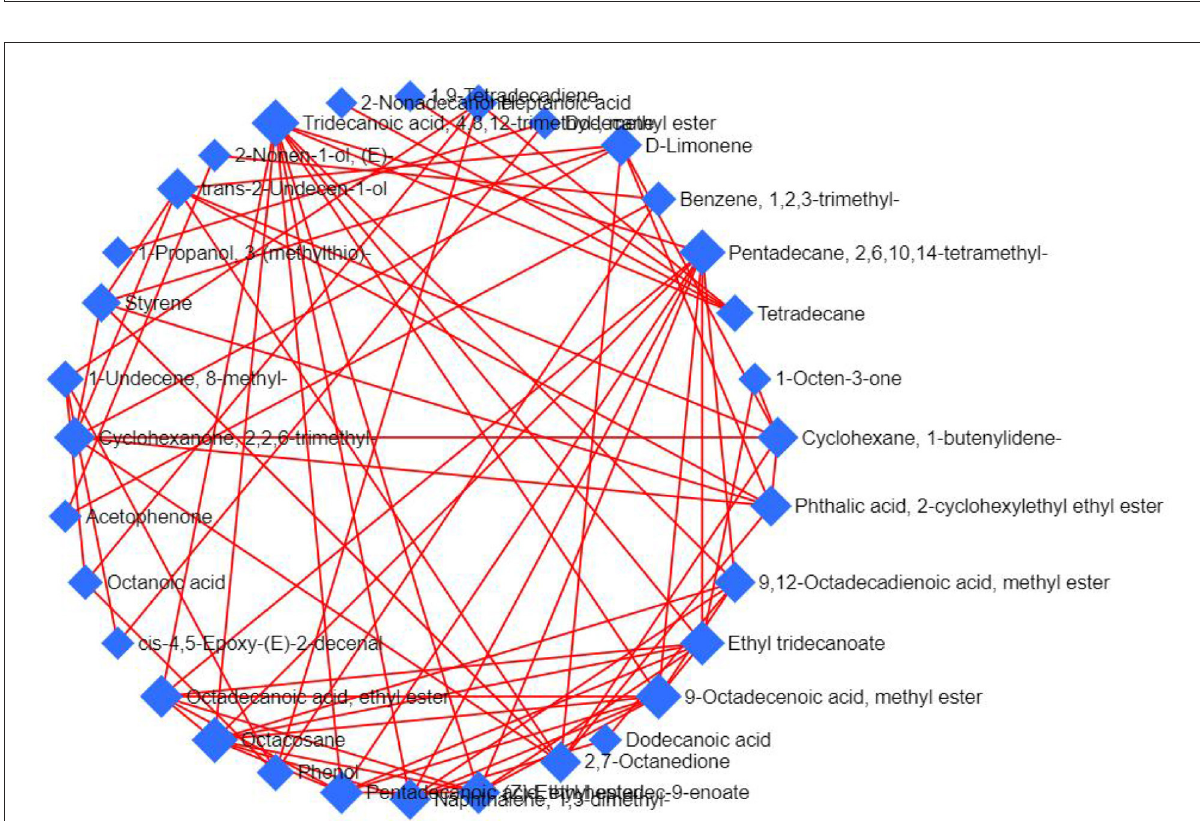
FIGURE8 DSPC volatile components network. The network was constructed using the targeted and untargeted data.